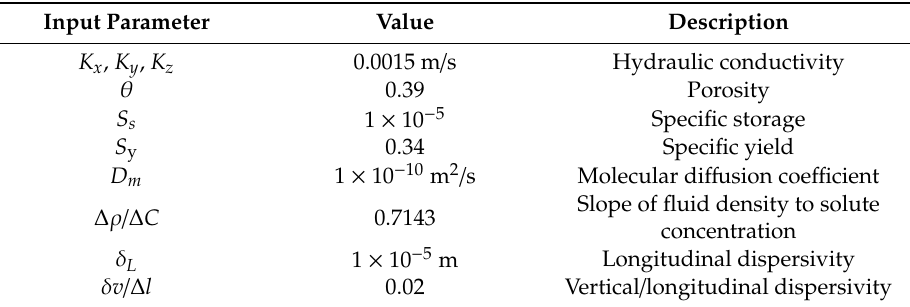
Figure 4. Conceptual diagram of the numerical model with domain dimensions, boundary conditions, and observation well locations. Table 1. Initial model parameters.